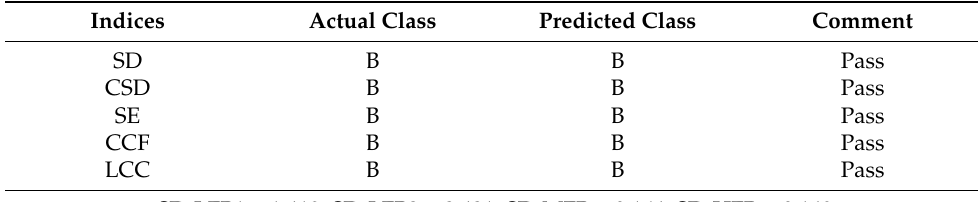
Table 5. Performance metrics of ANN for different indicators in assessing case